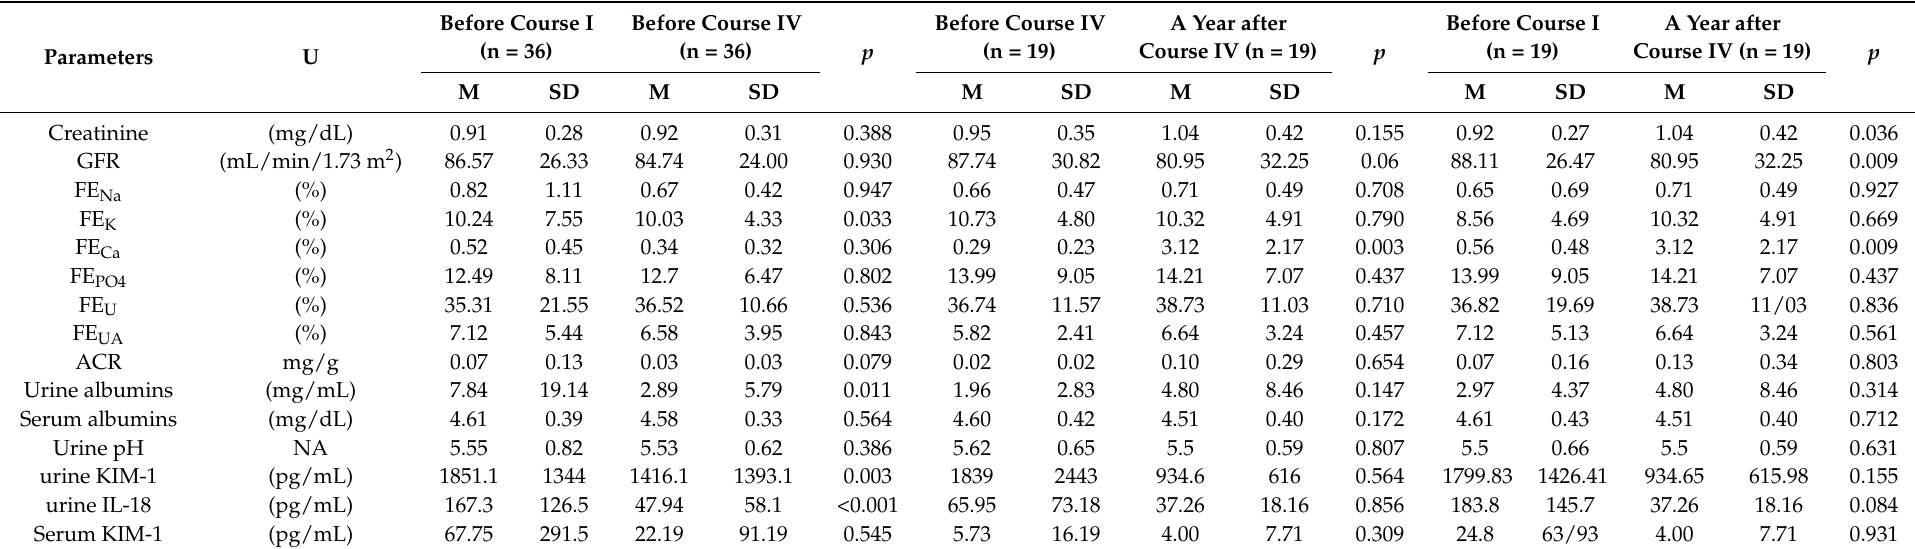
Table 5. Summary of renal parameters at different times of evaluation.